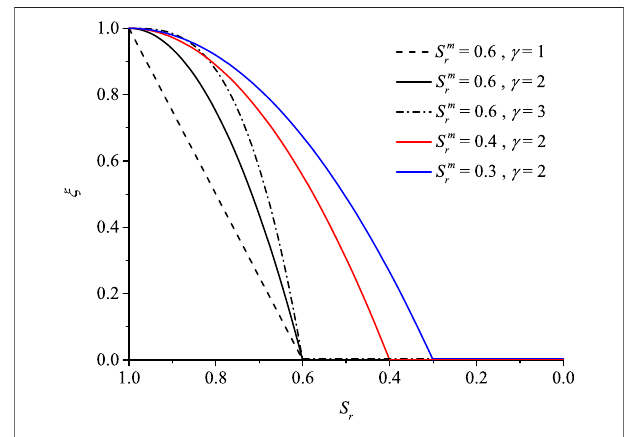
FIGURE 2 | Participation function characteristic curve.